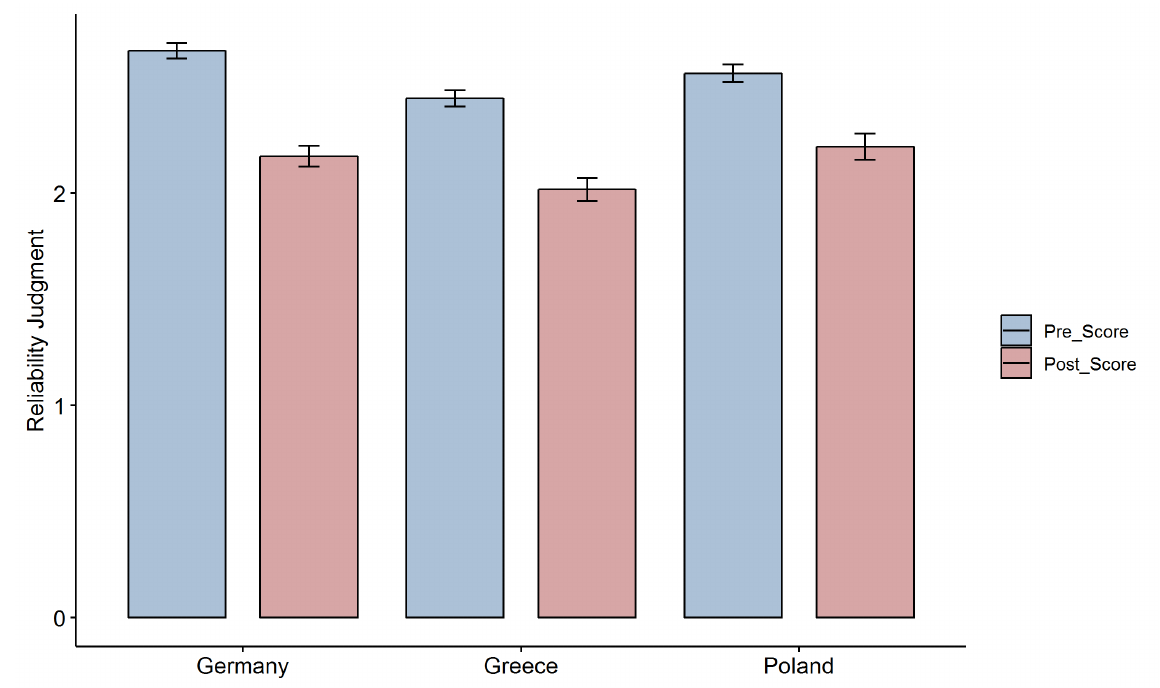
Figure 3. Average perceived reliability judgments for the fake news scale across countries pre and post gameplay (Germany, Greece, and Poland). Error bars represent 95% confidence intervals. The figure shows that the average perceived reliability of fake news items goes down significantly after gameplay in each country. All pre and post means for the individual items can be found in the methodology